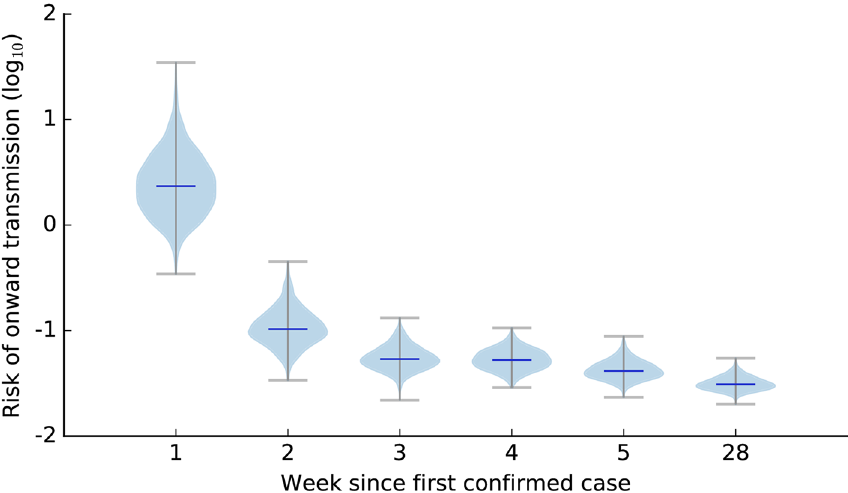
Fig 1. Instantaneous risk of onward transmission of foot-and-mouth disease in UK 2001 in first 5 weeks and the final week. Calculated as the infectious pressure from an average-sized infectious farm to an average-sized susceptible farm integrated across both the joint parameter distribution at the time point in question, and from 0 to 20km. Note that the instantaneous risk of transmission indicates the overall relative risk of transmission, which does not have a direct epidemiological interpretation but provides a direct comparison across